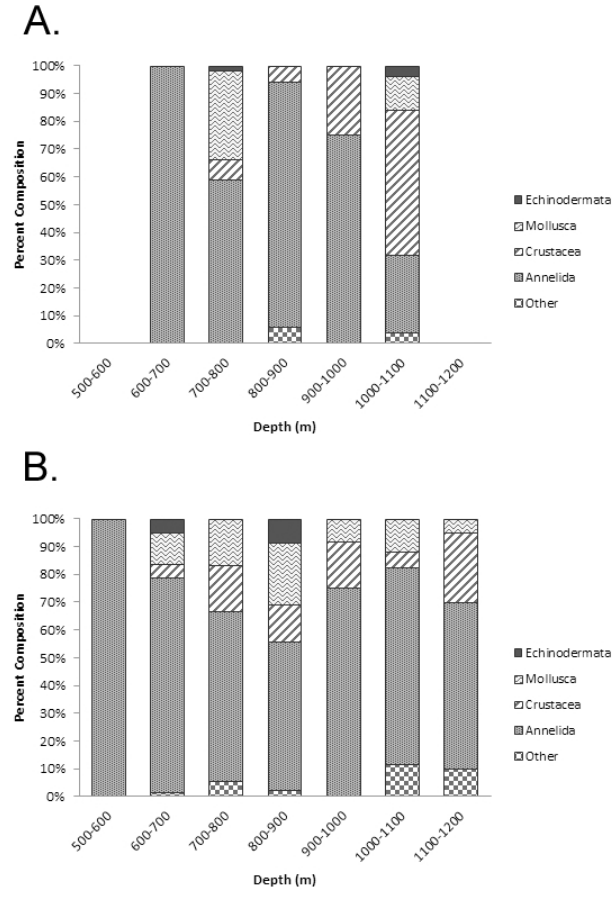
Fig. 4. Metazoan macrofaunal composition in ambient sediments sampled across the W. Indian margin along transect 1 (A) and tran- sect 2 (B)